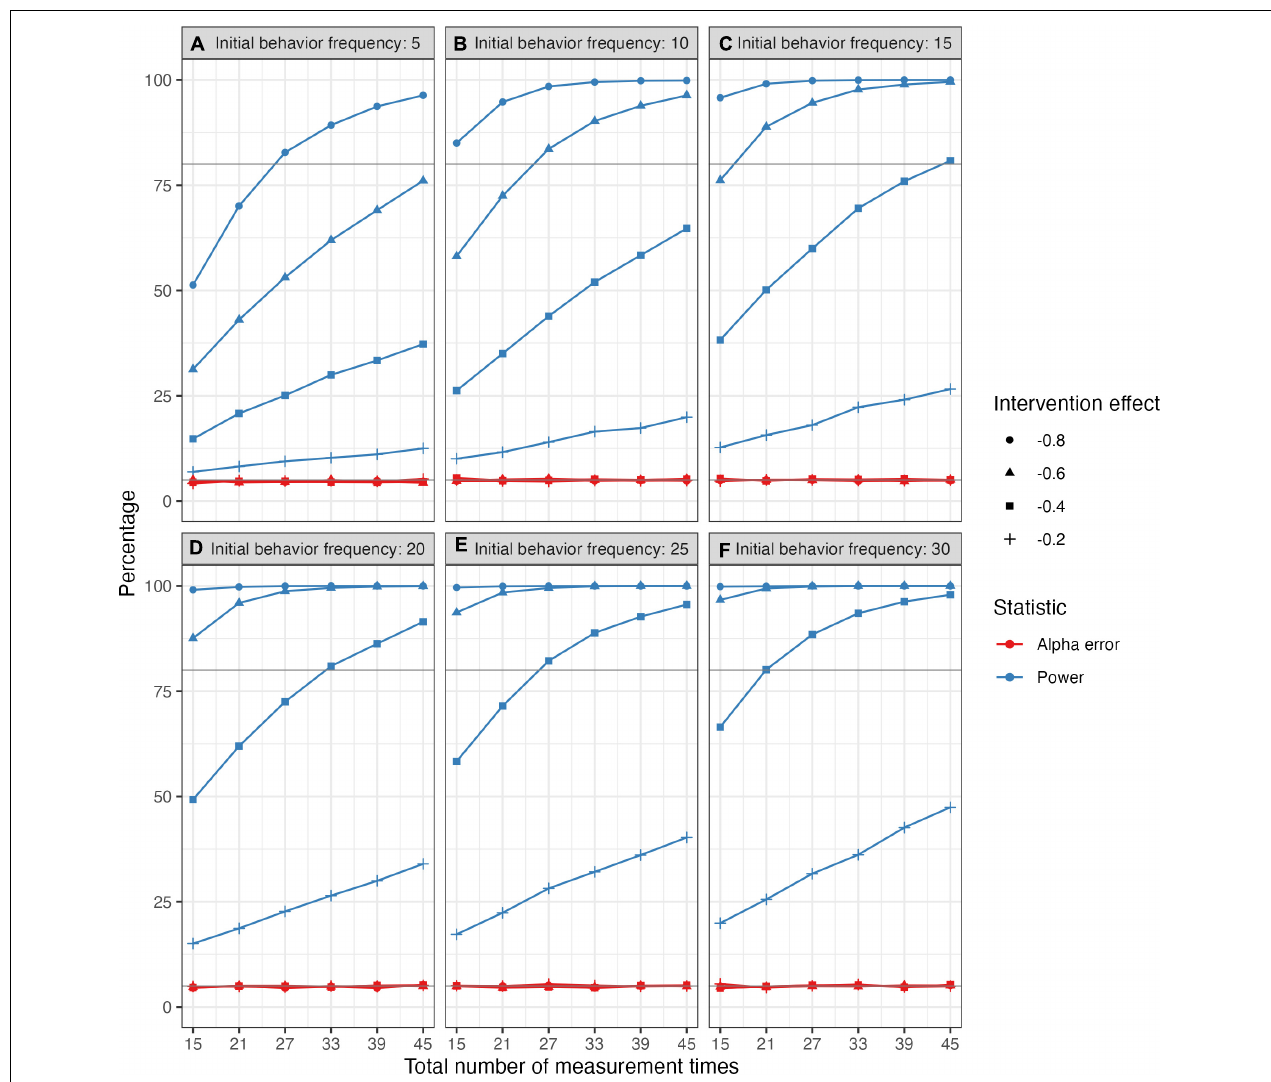
FIGURE 4 | Power and alpha error probability (line colour) for different intervention effect sizes (dot shape), initial behavior frequency (part), and number of measurement times ( x -axis) (simulation